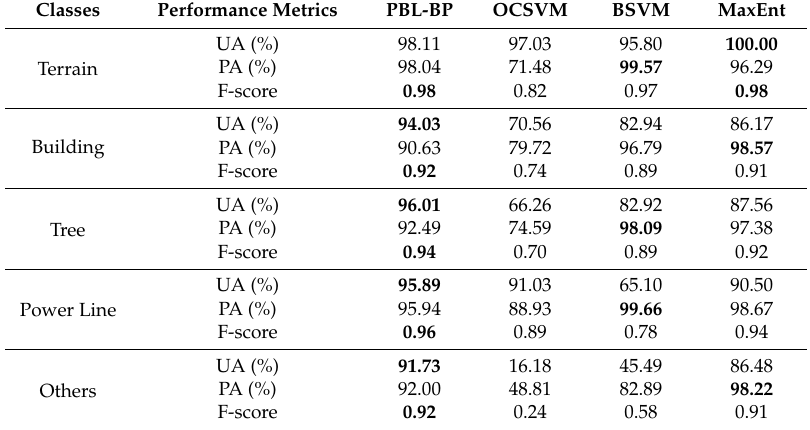
Figure 2. One-class classification results of presence and background learning algorithm implemented by back propagation neural network (PBL-BP), one-class support vector machines (OCSVM), biased SVM (BSVM) and maximum entropy (MaxEnt): ( a ) Terrain; ( b ) Building; ( c ) Tree; ( d ) Power Line; ( e ) Others. Table 1. Accuracy assessment for One-class classification results of PBL-BP, OCSVM, BSVM and MaxEnt.